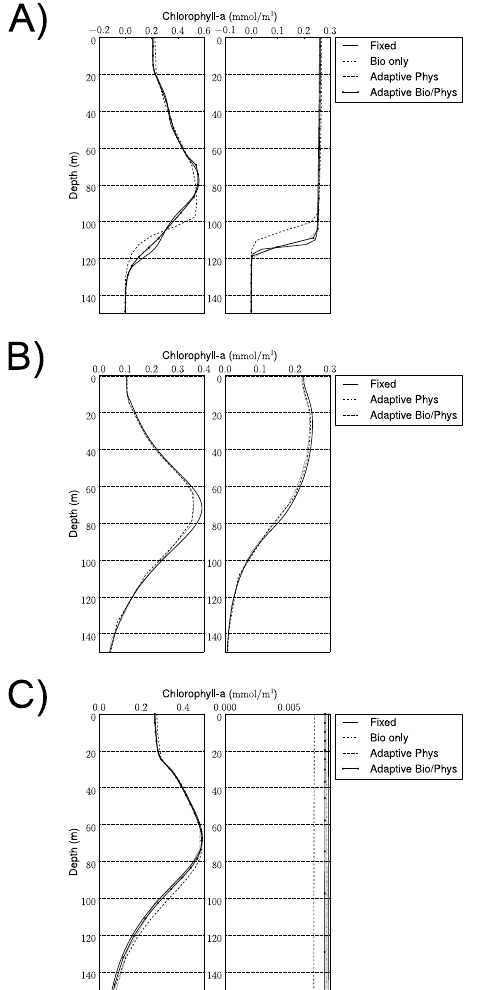
Fig. 15. Vertical profiles of chlorophyll at (A) Station Papa, (B) Bermuda and (C) Station India over the top 150m, 150m and 200m respectively comparing the performance of different adaptiv- ity metrics. The left-hand column shows the profile in summer (day 182) and the right-hand column shows the profile in winter (day 365). Note that all metrics, bar biology only, show similar